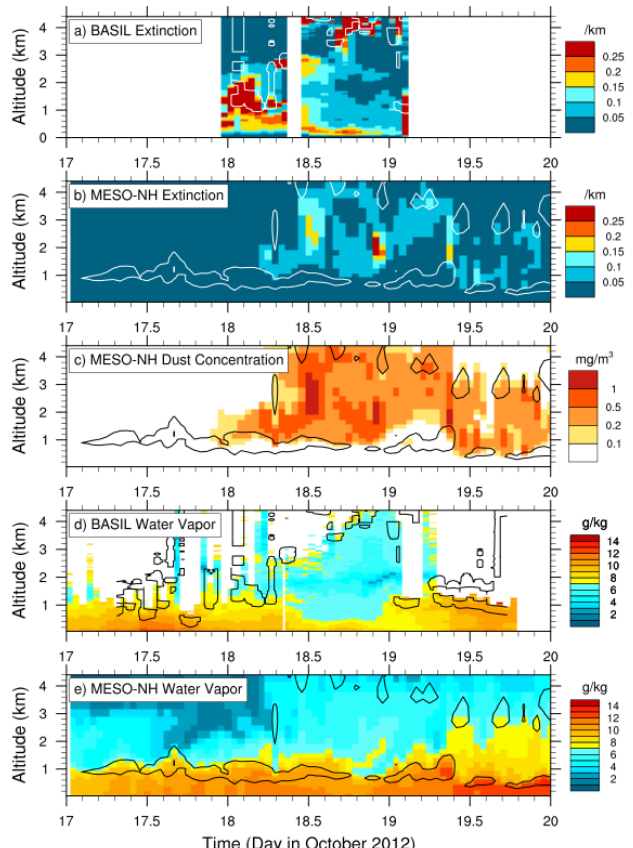
Figure 6. Time–height series of extinction coefficients derived from (a) BASIL at 355nm and (b) the Meso-NH DUST simulation – valid for the spectral range 0.25–0.44µm – over Candillargues between 00:00UTC on 17 October and 00:00UTC on 20 October 2012. Missing BASIL data appear in white. (c) Same as (b) but for dust aerosol concentration derived from the Meso-NH DUST simulation. (d) and (e) same as (a) and (b) but for the water vapor mixing ratio. The cloud layers in the Meso-NH DUST simulation are shown using a cloud condensate mixing ratio of 0.005gkg − 1 (white contour in b and black contour in d ). The cloud mask in (a) and (c) is based on the BASIL extinction coefficient, using a threshold of 0.25km − 1 . Hence, the presence of clouds is shown by the white contours in (a) and the black contours in (d) , respectively.